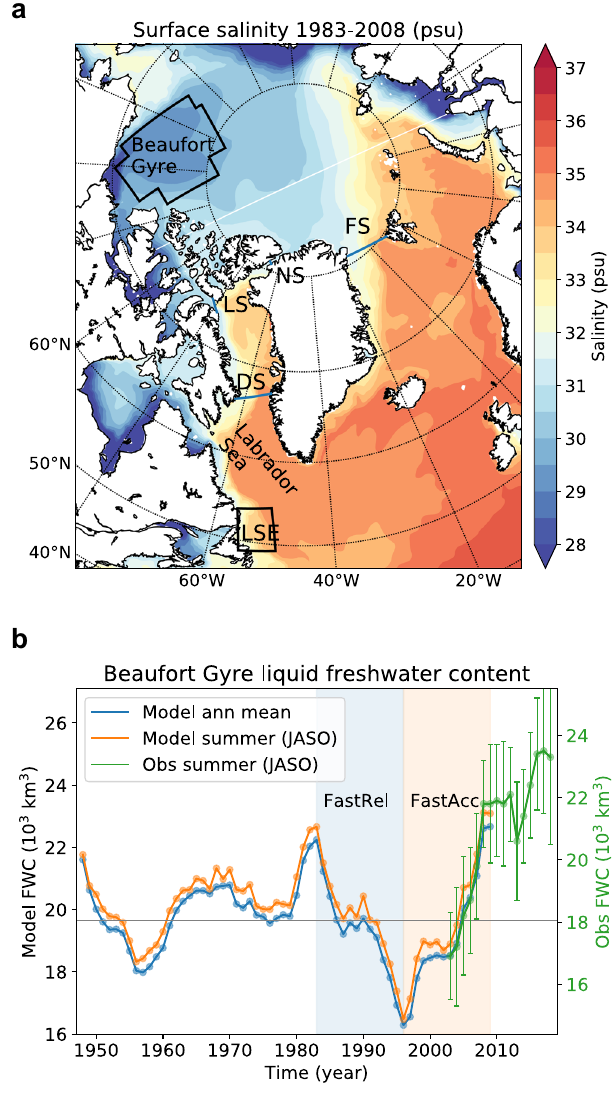
Fig. 1 Study region showing the Beaufort Gyre (BG) and major ocean gateways, as well as the BG freshwater content. a Climatological surface salinity in the Arctic and the North Atlantic in our HiLAT03 ocean sea-ice model for 1983-2008. Black zigzag box indicates the BG region. Black box exit of Labrador Sea (LSE), NS Nares Strait, LS Lancaster Sound, DS Davis Strait, FS Fram Strait. b Annual mean (blue) BG liquid freshwater content relative to 34.6 psu, which is the modeled mean salinity of the Arctic Basin (Supplementary Note 1). Its mean value of 19,660 km 3 is indicated by the horizontal gray line. The summer average (July – October; orange) is also shown to be compared with the 2003 – 2018 observation 64 (green with error bars indicating root-mean-square error of freshwater content interpolation; an offset of 1600 km 3 ). FastRel and FastAcc are tracer experiments for 1983 – 1995 and 1996 – 2008,